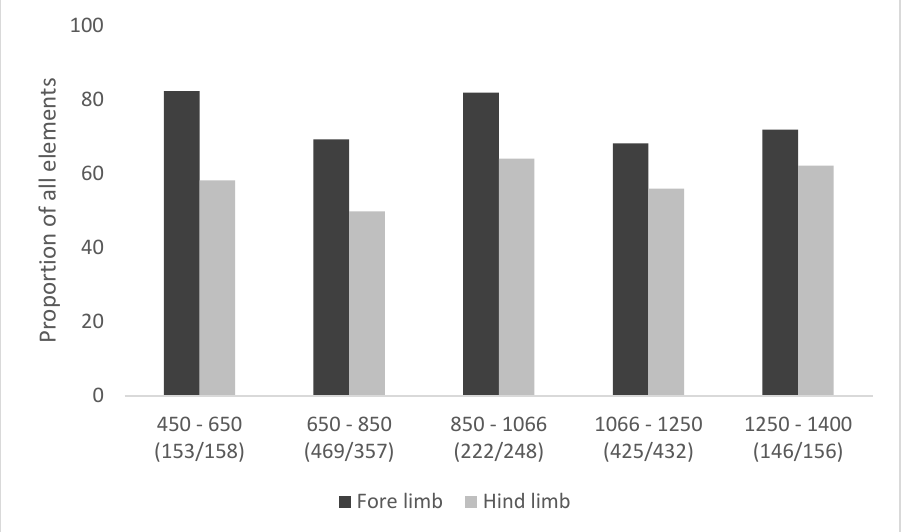
Figure 5. Cattle foot pathology data showing prevalence (proportion of all elements affected) through time. Data from targeted sites. ( n / n ) = number of elements from the fore and hind limbs.